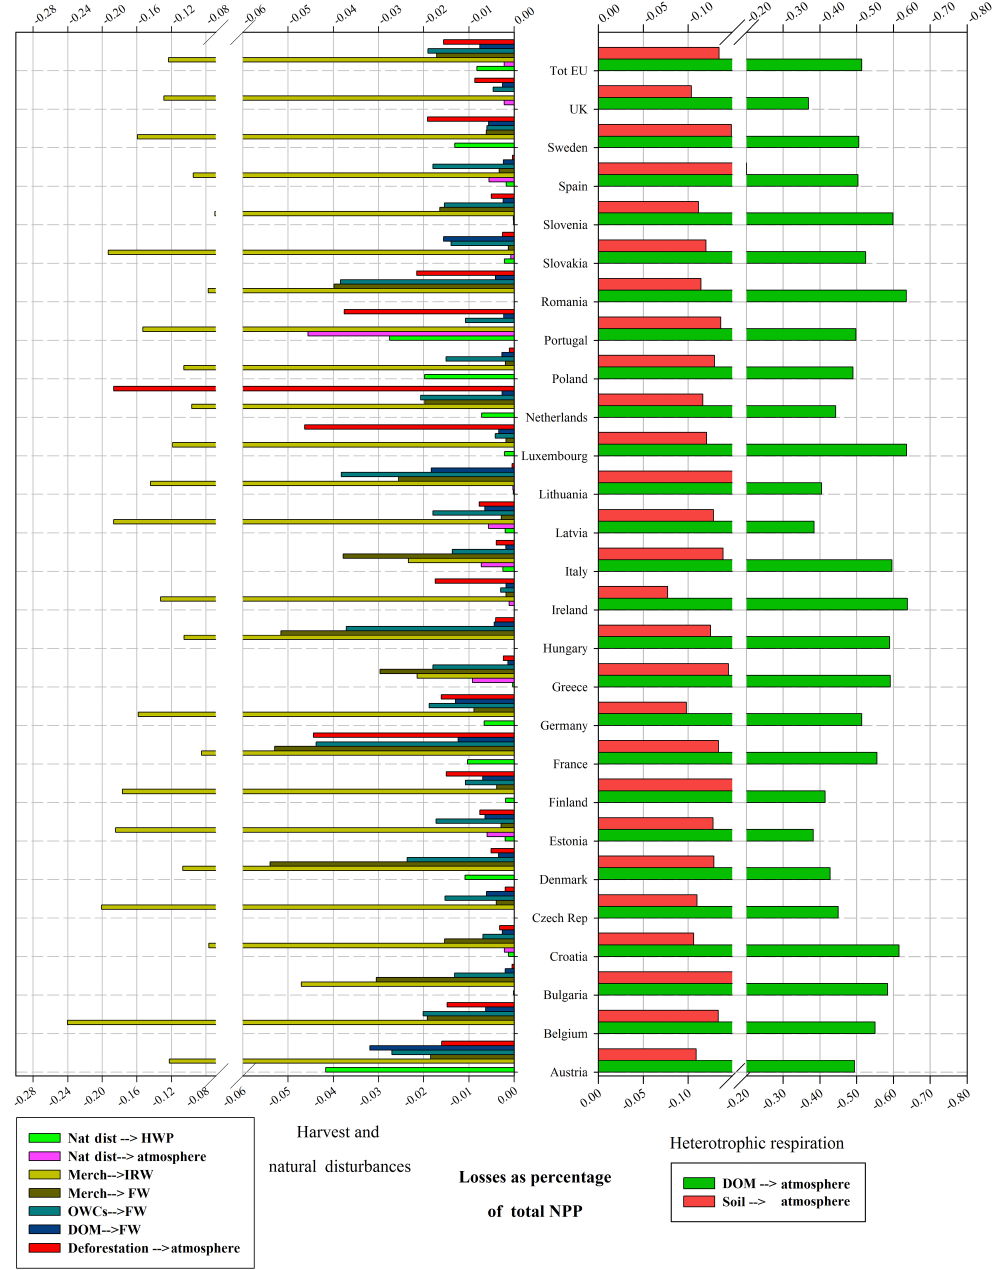
Figure 5. Relative amount of C loss estimated as percentage of the total NPP due to (i) the release of C to the atmosphere for the decompo- sition of DOM and soil pools, in the right panel, and (ii) natural disturbances (i.e., fires), human activities (harvest) and deforestation, in the left panel. Here we report the relative share of losses due to (i) salvage logging after natural disturbances (Nat dist → HWP), (ii) release of C to the atmosphere due to natural disturbances (Nat dist → atmosphere), (iii) merchantable wood used as IRW (Merch → IRW), (iv) mer- chantable wood used as FW (Merch → FW), (v) other wood components (i.e., branches, tops) used as FW (OWCs → FW), (vi) snags used as FW (DOM → FW) and (vii) release of C to the atmosphere due to deforestation (Deforestation →